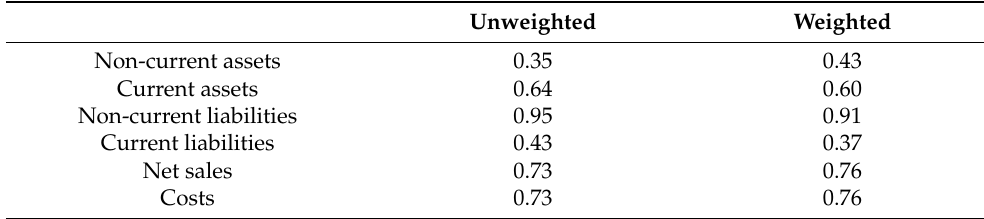
Table 4. Proportion of CLR variance explained by the weighted and unweighted classifications in an ANOVA model.